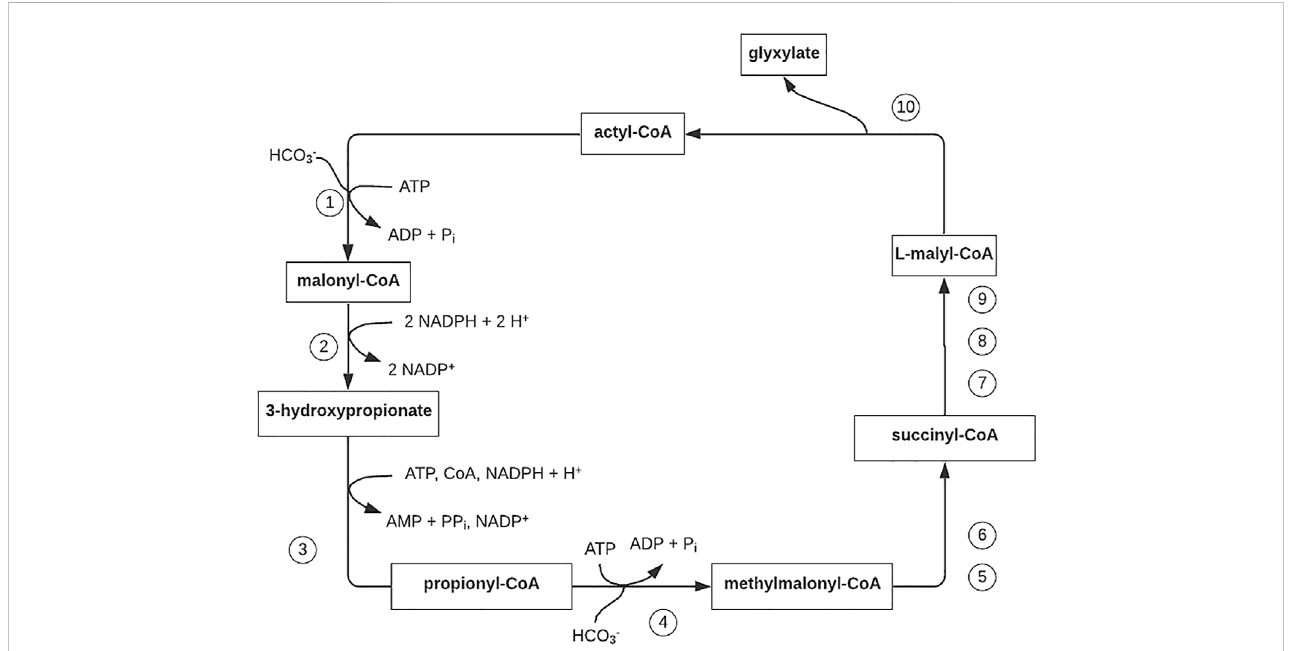
FIGURE 5 3-Hydroxypropionate cycle of autotrophic CO 2 fi xation in the phototrophic green non-sulfur eubacterium Chloro fl exus aurantiacus. Figure redrawn after reference (Alber et al., 2008). Step 1, acetyl-CoA carboxylase; step 2, malonyl-CoA reductase (bifunctional; step 3, propionyl-CoA synthase (trifunctional); step 4, propionyl-CoA carboxylase; step 5,methylmalonyl-CoA epimerase; step 6, methylmalonyl-CoA mutase; step 7, succinyl-CoA – L- malate CoA transferase; step 8, succinate dehydrogenase (electron acceptor unknown); step 9, fumarase; step 10, L-malyl-CoA/ β -methylmalyl-CoA lyase